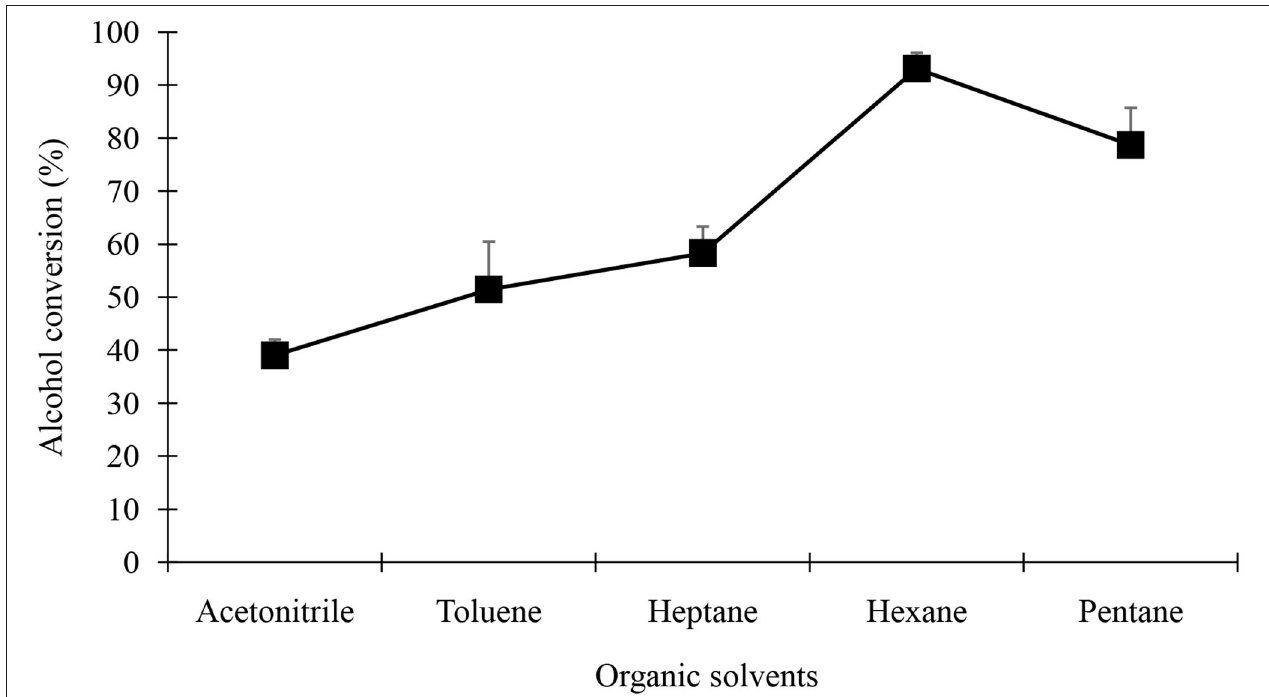
FIGURE 9 | Effect of organic solvents for the synthesis of geranyl butyrate ester. The reaction mixture consist of 0.25M of each of butyric acid and geraniol at 37 o C in the presence of 0.25 g/5ml of from black cumin seedling acetone powder of day 4th of germination.